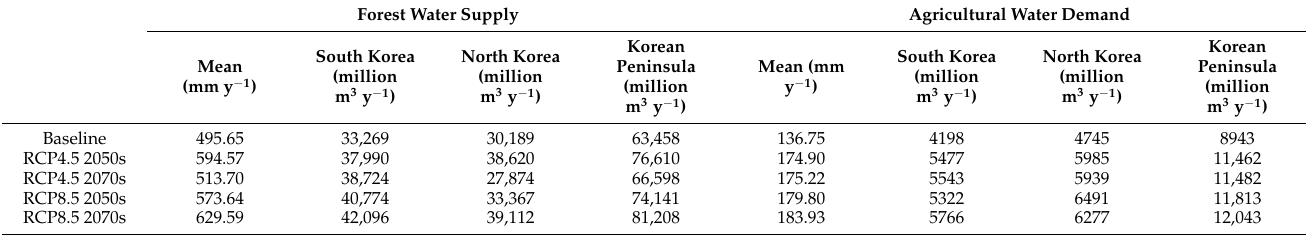
Table 3. Statistics of agricultural water demand and forest water supply under baseline and future climate